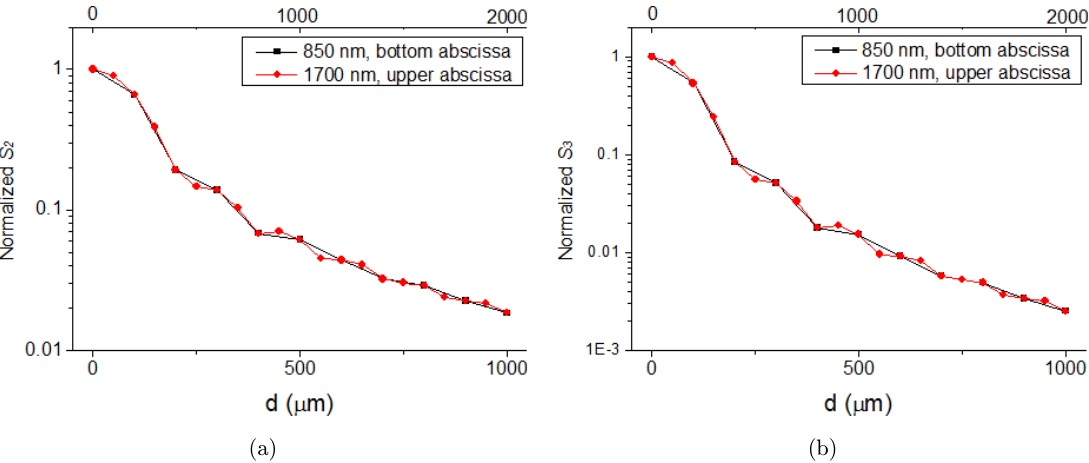
Fig. 5. Normalized (a) S 2 and (b) S 3 vs imaging depth for 850-nm and 1700-nm excitations. S 2 and S 3 were normalized to those at the surface ( d ¼ 0). The abscissas are di®erent for 850-nm (bottom abscissa) and 1700-nm (upper abscissa) excitation wavelengths. Also NA ¼ 1 : 05, n 1 ¼ 1 : 33 and n 2 ¼ 1 : 36.